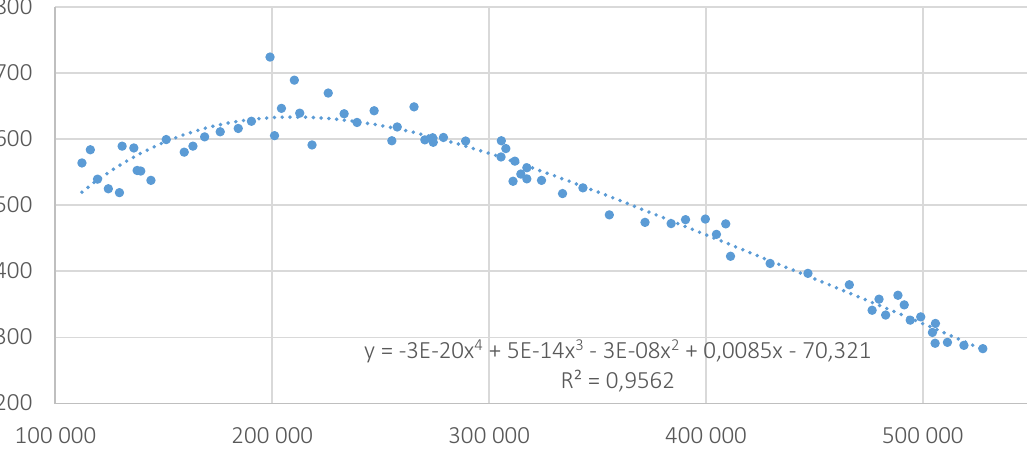
Figure 5. Energy Intensity in Gigajoule derived units vs GDP per capita in 2015-NOK, 1950–2019